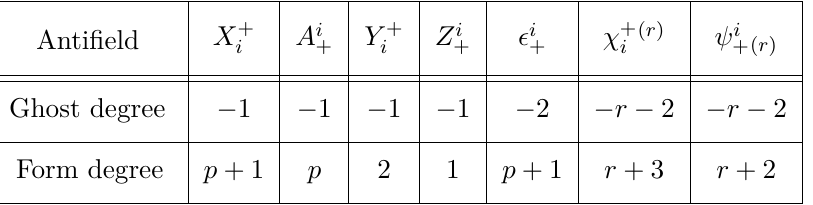
Table 2 . The antifields and antighosts of the twisted R-Poisson sigma model in p + 1 dimensions. The range of r is the same as for the corresponding